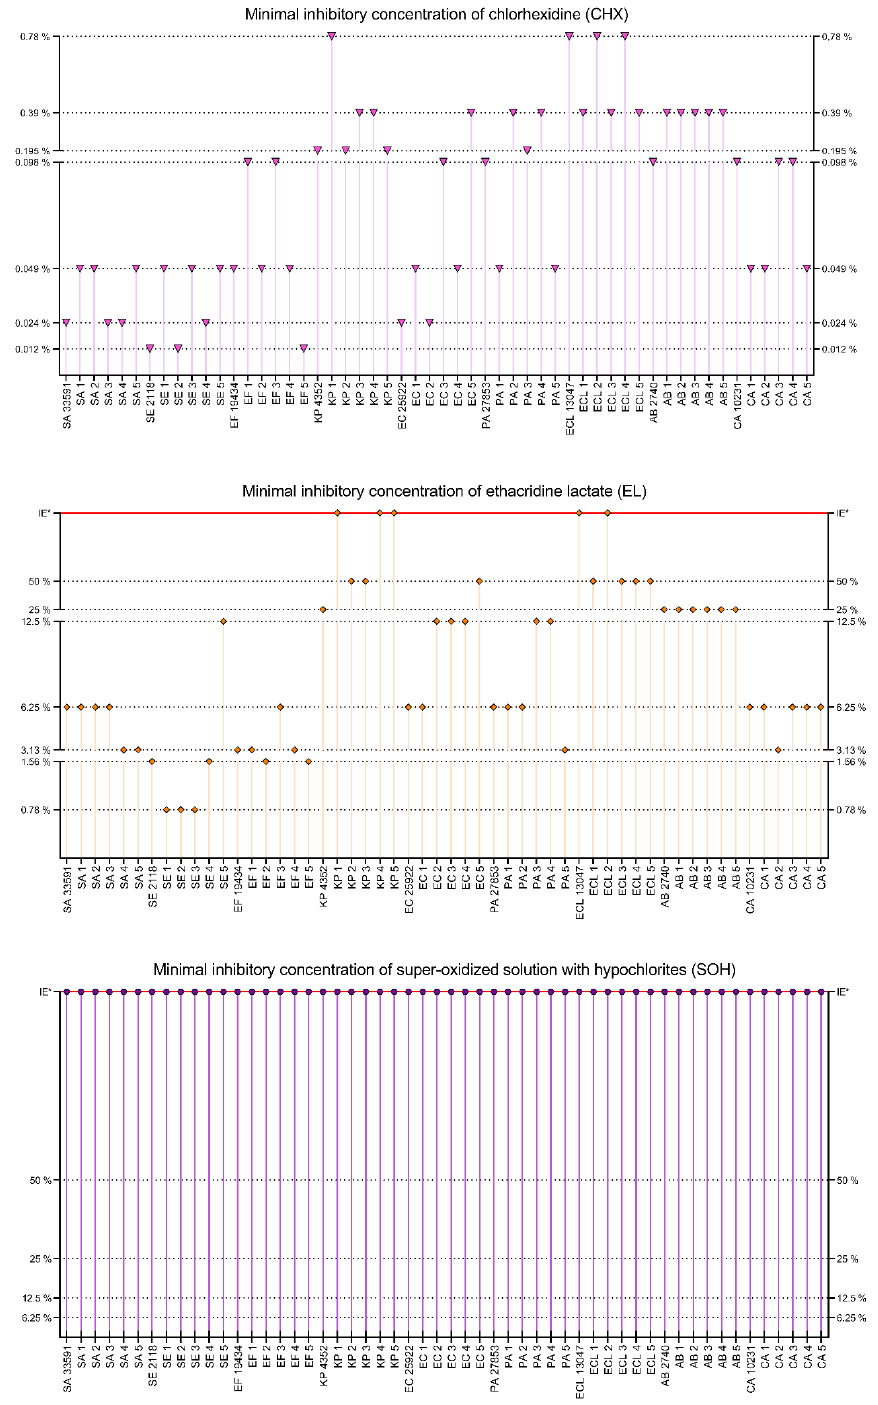
Figure 6. Minimal inhibitory concentrations of CHX, EL and SOH, presented as a percentage of working solutions (concentration provided by the manufacturer). Tested compounds: CHX — chlorhexidine, EL — ethacridine lactate, SOH — super-oxidized hypochlorites solution (water solution of chlorhexidine diluted to 0.5% of CHX, Rivanol ® 0.1% of EL and Microdacyn ® 0.004% + 0.004% of NaOCl and HOCl). Tested strains: SA — Staphylococcus aureus , SE — Staphylococcus epider-